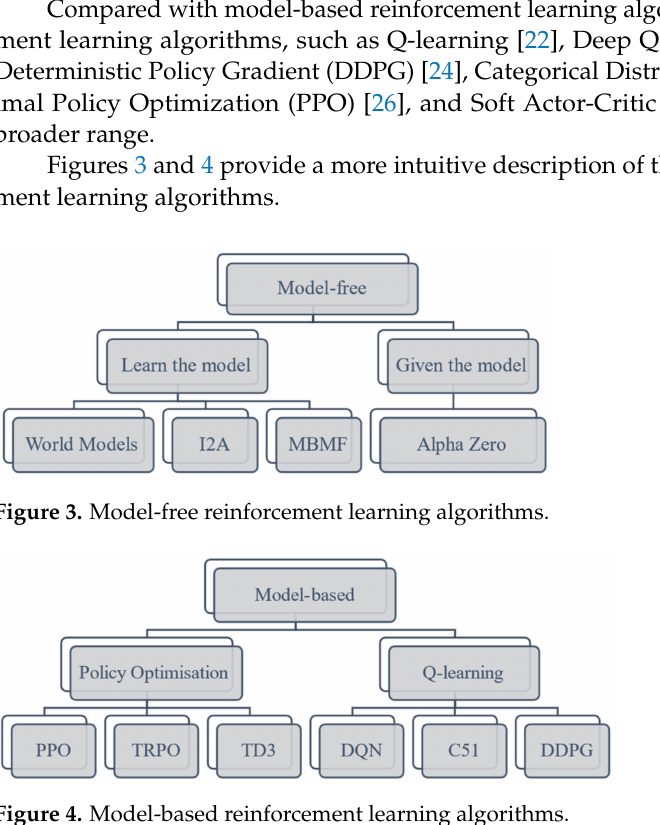
Figure 4. Model-based reinforcement learning algorithms.